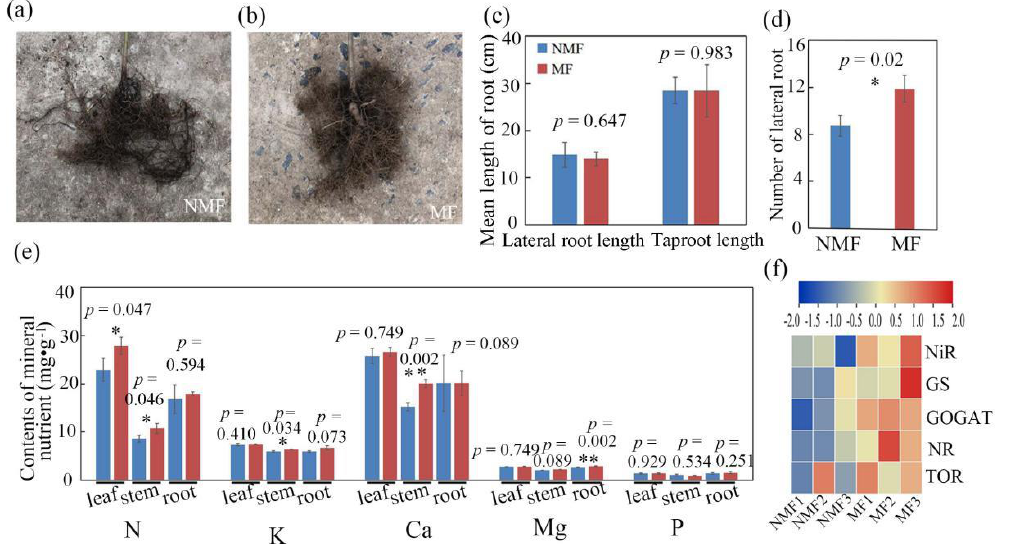
Figure 3. Influence of mycorrhizal fungal colonization on root traits and mineral nutrients in C. paliurus . ( a , b ) the root picture of inoculated and non − inoculated seedings; ( c , d ) the mean length and number of roots; ( e ) changes of mineral nutrients after inoculation with mycorrhizal fungi; the total content of nitrogen (N), potassium (K), calcium (Ca), magnesium (Mg), and phosphors (P) were measured; ( f ) clustering heat map of the DGEs in nitrogen assimilation pathway. NR, nitrate reductase; NiR, nitrite reductase; GS, glutamine synthetase; GOGAT, glutamate synthase; TOR, target of rapamycin. * p < 0.05 and ** p < 0.01 indicate significant differences between inoculation and non-inoculation in two-tailed Student’s tests. The color in the heat map represents the corresponding FPKM value of